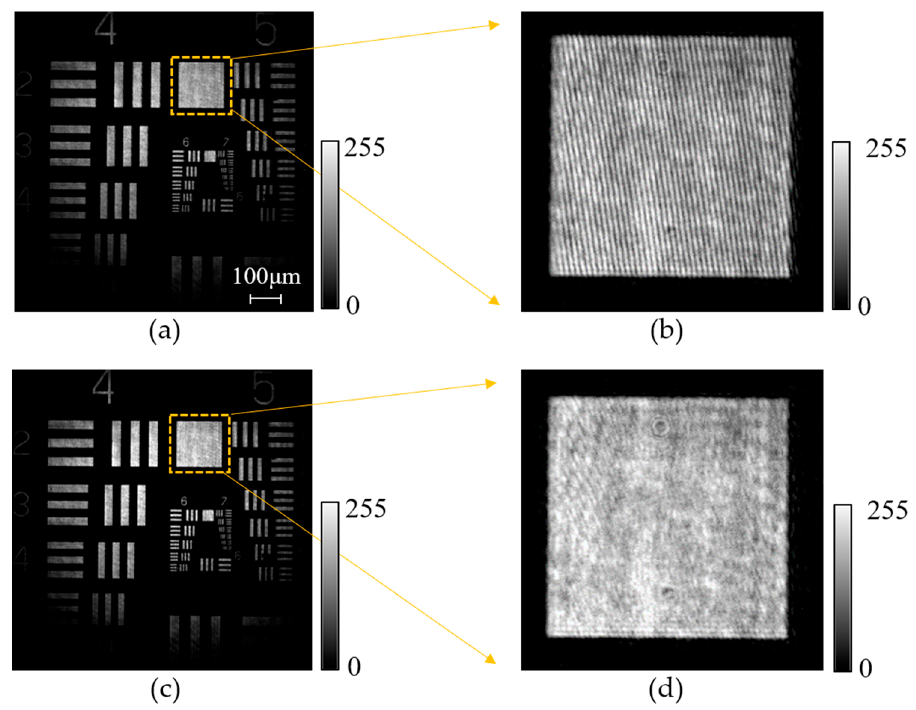
Figure 8. Experimental results of the amplitude images. ( a , c ) Amplitude images reconstructed by the conventional method and the proposed method, respectively; ( b , d ) Magnified images of the areas indicated in ( a , c ), respectively. Appl. Sci. 2018 , 8 , x FOR PEER REVIEW